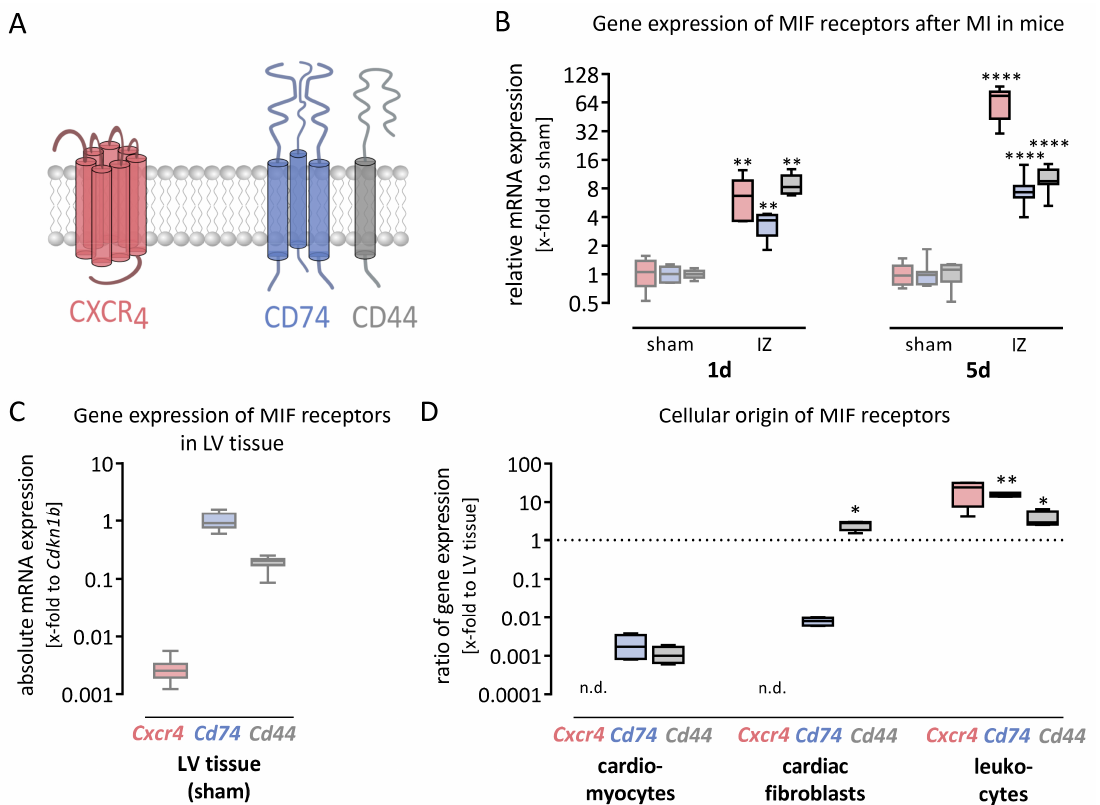
Figure 2. MIF receptors Cxcr4 and Cd74/Cd44 are expressed in cardiac tissue and upregulated after MI as a result of recruited leukocytes. ( A ) MIF and MIF-2 can bind to the G protein-coupled receptor CXCR4 (red) as well as the heterodimer CD74/CD44 (blue/grey) leading to different intracellular signaling. ( B ) The gene expression levels of all three transmembrane proteins were highly increased after myocardial infarction. Gene expression levels are shown as relative mRNA expression (x-fold to sham operated mice) using the formula 2 − ∆∆ Ct and presented in box plots (min to max). Gene expression data represent 6–8 sham operated mice and 5–11 mice with MI. ( C ) The gene expression levels of all three transmembrane proteins were determined in healthy LV tissue collected from mice after sham operation. While the expression of Cxcr4 is very low, Cd74 and Cd44 forming the heterodimeric MIF receptor were well expressed in healthy LV tissue. Basal gene expression levels are shown as absolute mRNA expression (x-fold to the housekeeping gene Cdkn1b ) using the formula 2 − ∆ Ct and presented in box plots (min to max). ( D ) The basal gene expression levels of Cxcr4 , Cd74 and Cd44 were determined in cardiomyocytes, cardiac fibroblasts and leukocytes. To evaluate the cellular origin of the receptor expression in LV tissue, the ratio between the detected gene expression in the distinct cell type and the expression level in LV tissue was plotted. Those cells with a ratio lower than one contribute less to the receptor expression detected in the whole cardiac tissue. As depicted in red, the Cxcr4 receptor is not expressed in both resident cardiac cell types, cardiomyocytes and cardiac fibroblasts, whereas leukocytes were the main source of Cxcr4 within the LV tissue. The gene expression of the heterodimeric receptor Cd74/Cd44 , depicted in blue and grey, showed that cardiomyocytes, cardiac fibroblasts and leukocytes express both receptor components. While leukocytes are the main source of Cd74 expression, Cd44 is well expressed in leukocytes and additionally in cardiac fibroblasts, both highly abundant in the infarct zone after MI. * significantly different compared with sham operated mice ( B ) or cardiomyocytes ( D ). * p < 0.05; ** p < 0.01; **** p < 0.0001.